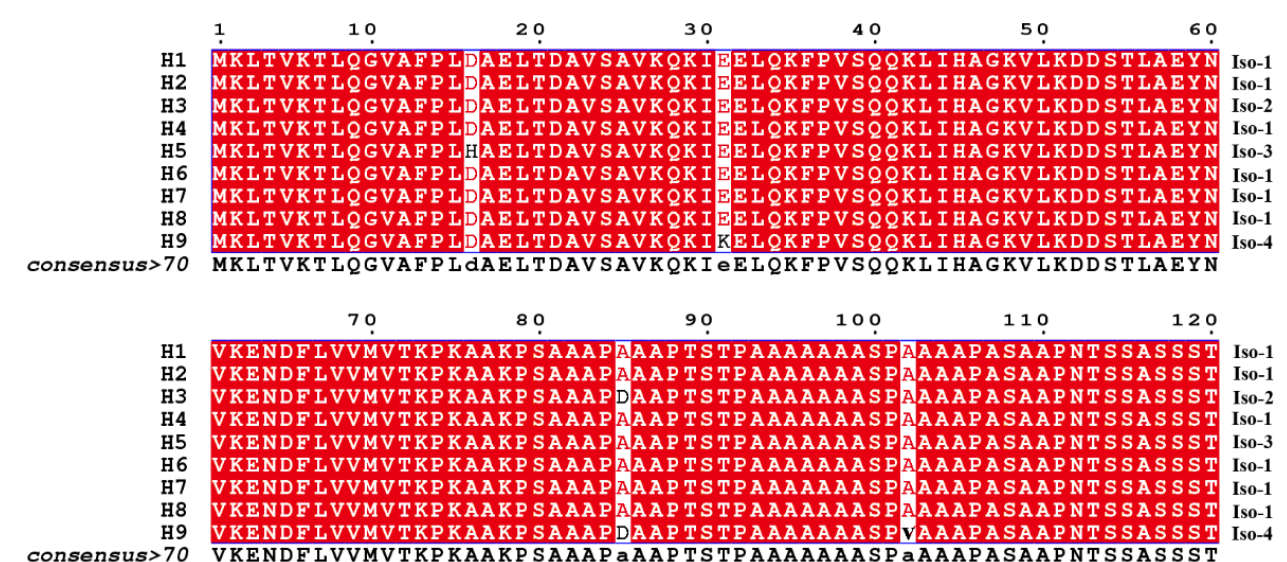
Figure 2. Sequence alignments of partial RAD23 isoforms deduced from nucleotide haplotypes. Different amino acids in the sequences are shown in black and shared amino acids are shown in white. The identical sequence of the isoforms in the C-terminal after the 121th amino acid is not shown. The consensus sequence (Global score > 0.70) is displayed in the last line, and the sequence alignment was performed by a ClustalW multiple approach and displayed by the online program, ESPript. Table 3. Frequency distribution of RAD23 haplotypes in the seven Phytophthora infestans populations sampled from China.